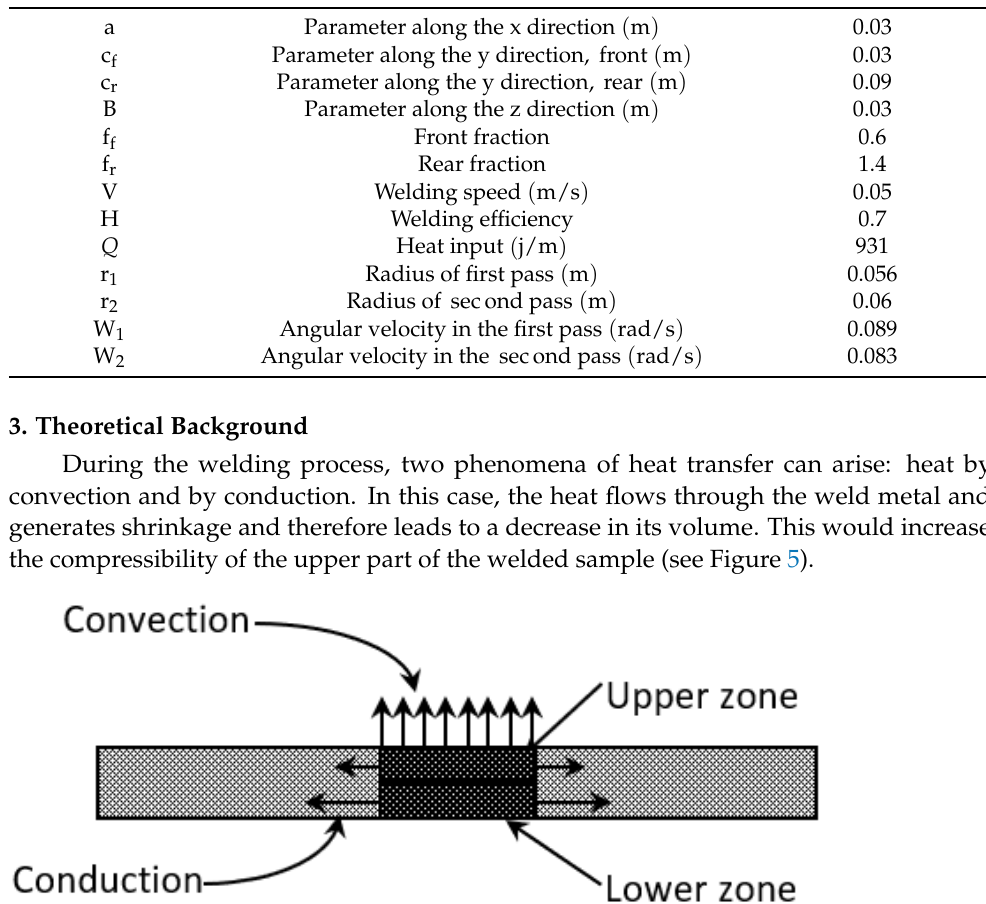
Figure 4. Plate geometry model.